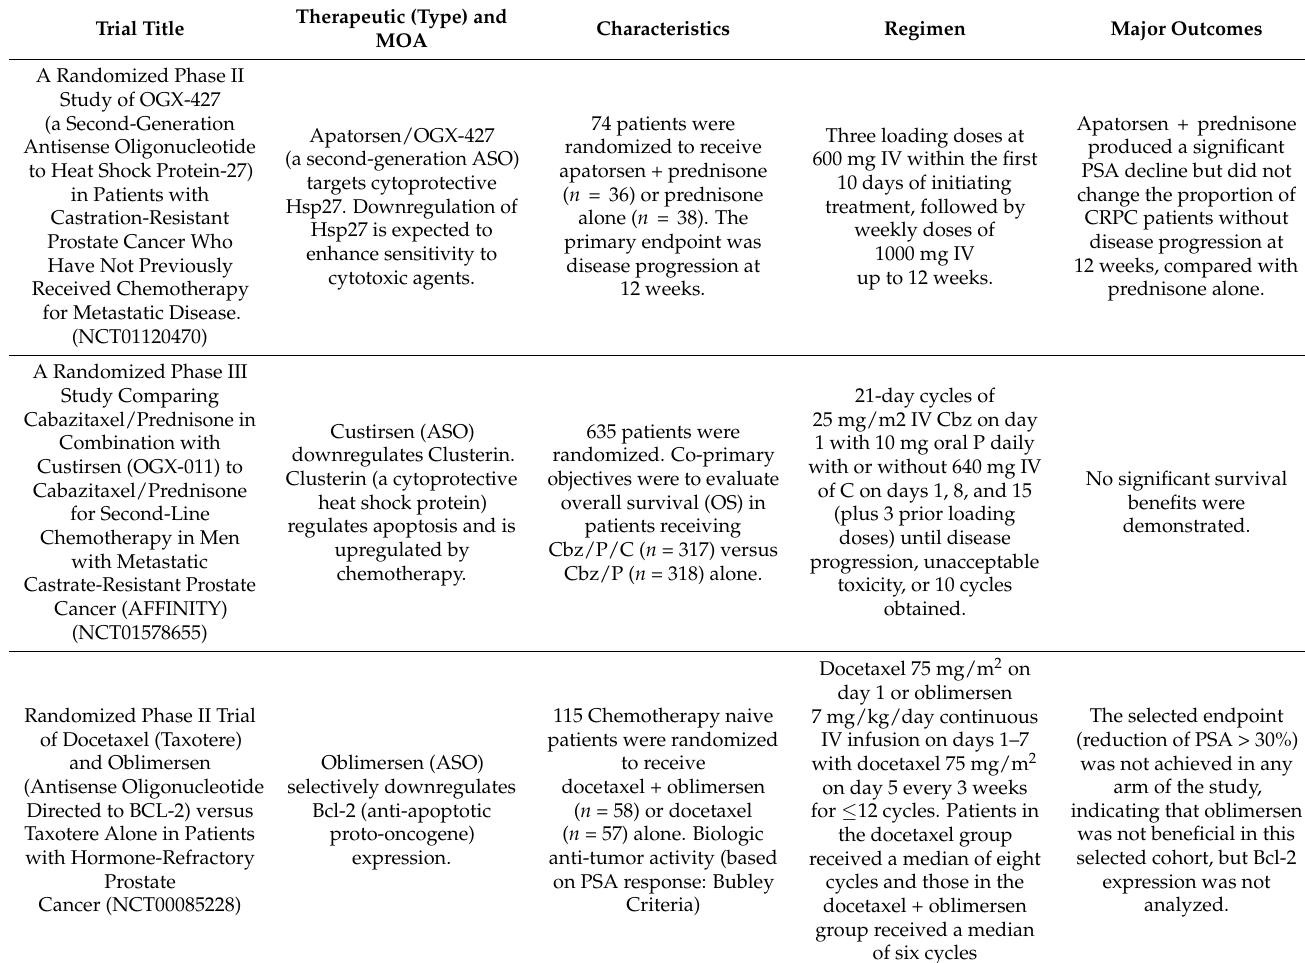
Table 1. Clinical trials for advanced prostatic carcinoma using ncRNA